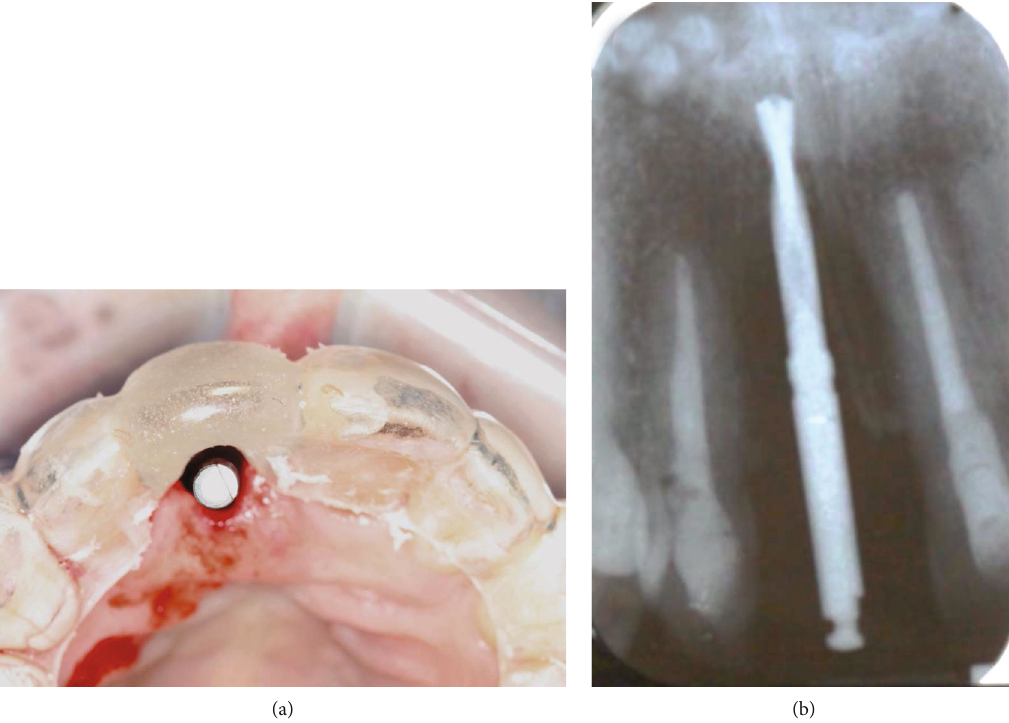
Figure 3: (a) Initial implant osteotomy was made at the cingulum region using a precision drill under the guidance of a surgical stent. (b) A periapical radiograph was taken with a 2mm twist drill to verify the depth and angulation for implant placement.